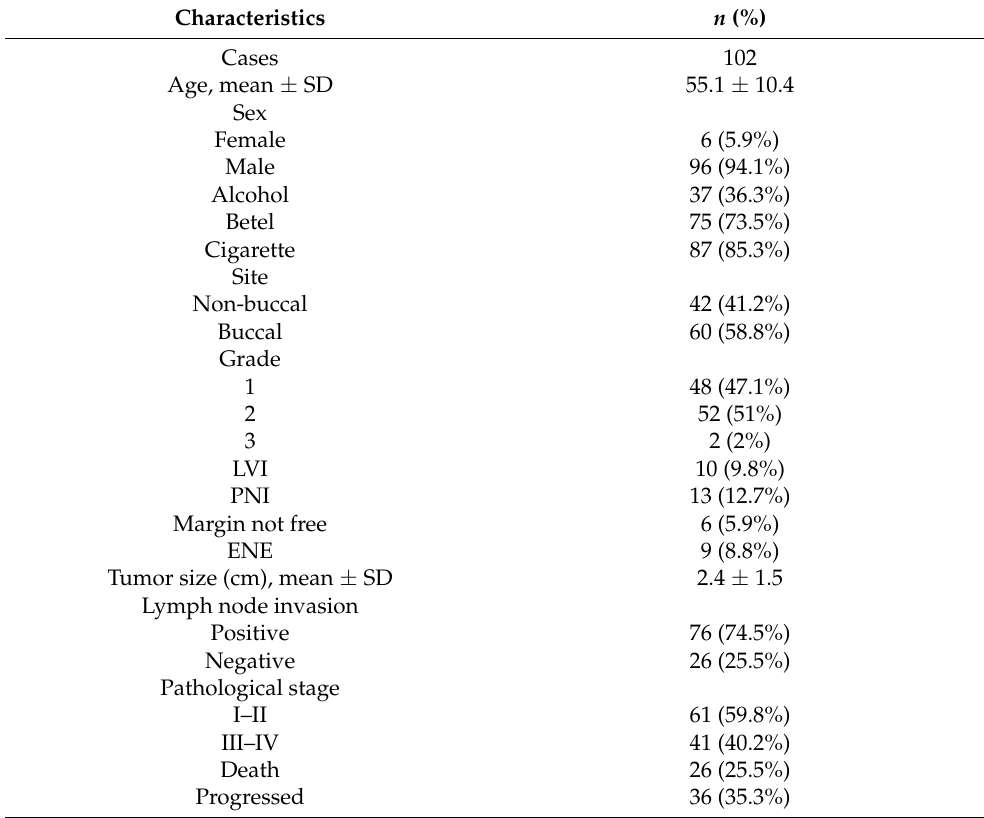
Table 1. Baseline